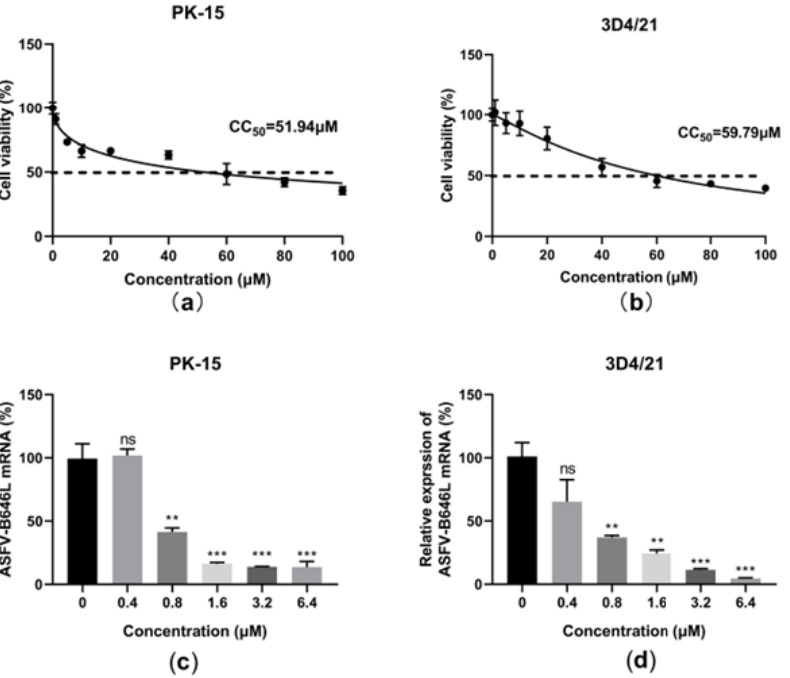
Figure 7. The effect of berbamine hydrochloride against the ASFV in PK-15 and 3D4/21 cells. The cell viability of berbamine hydrochloride in PK-15 ( a ) and 3D4/21( b ) was evaluated by MTT assay and CC 50 was calculated by GraphPad Prism 8.0. Inhibition of berbamine hydrochloride against ASFV B646L and CP204L gene transcription in PK-15 ( c ) and 3D4/21( d ) was evaluated by RT-qPCR. Each datum represents the results of three independent experiments (means ± SD). Significant differences compared with the control group are denoted with **, p < 0.01; ***, p < 0.001 and ns denotes no significant difference.